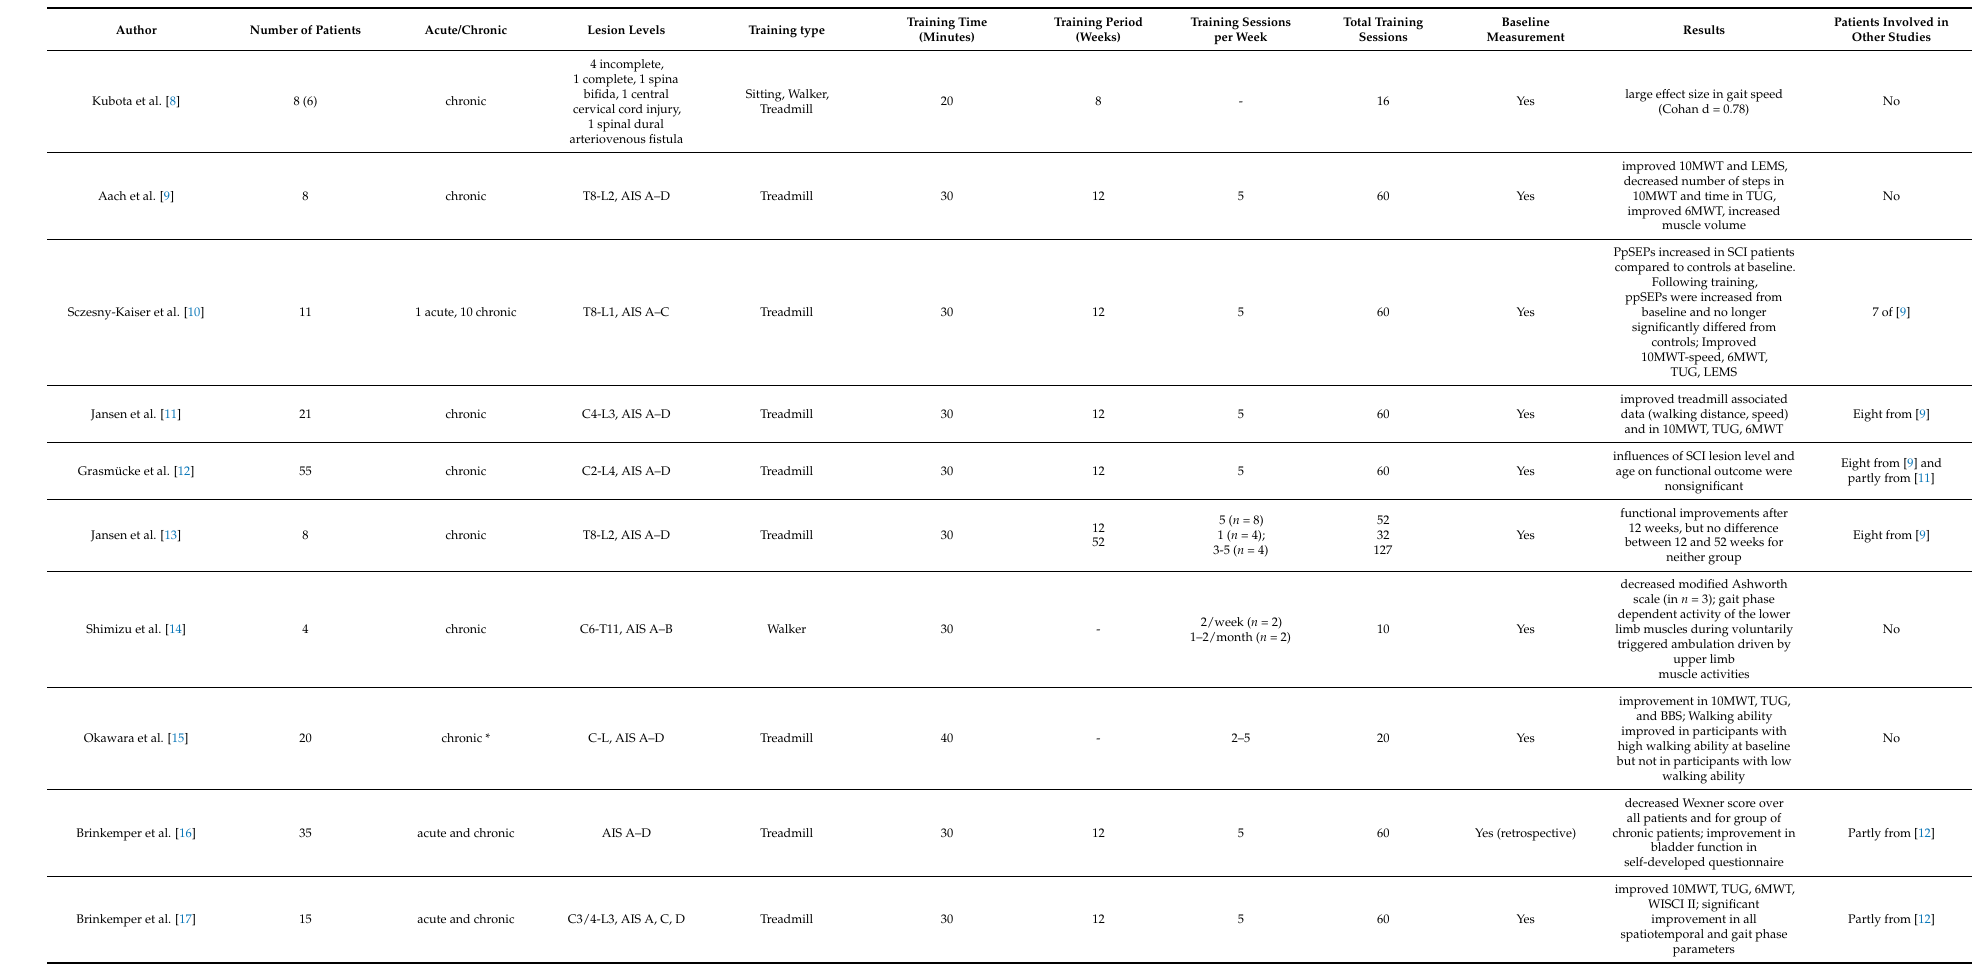
Table 1. Spinal cord injury clinical trials studies